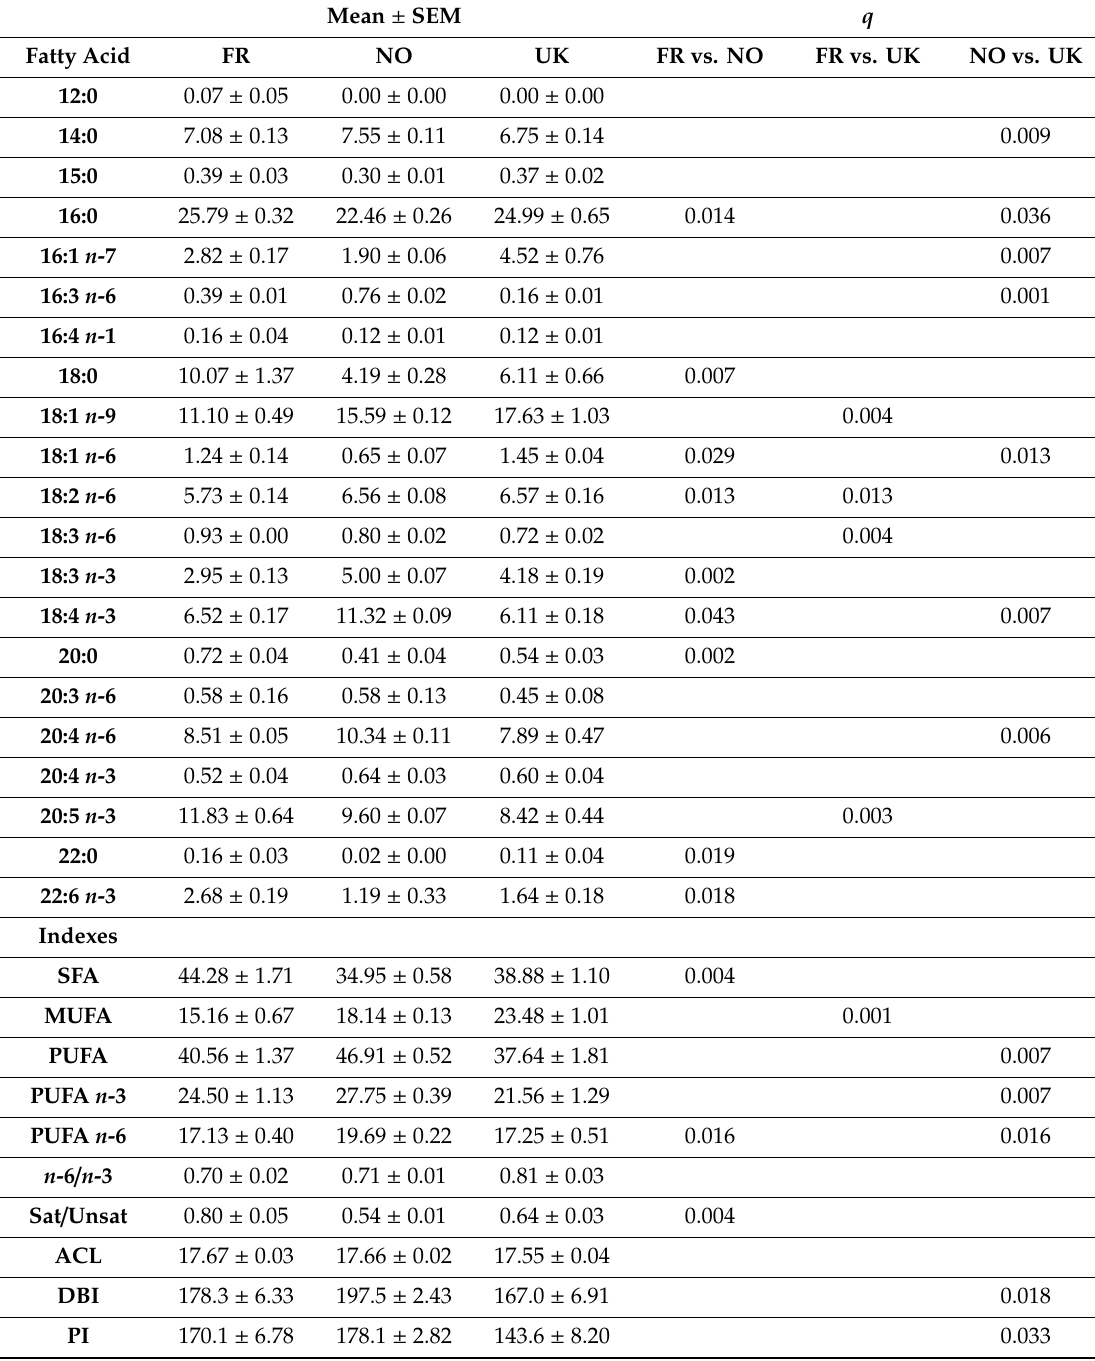
Table 1. Saccharina latissima fatty acid profile (%) of samples from di ff erent origins (FR—France; NO—Norway; UK—United Kingdom), derived nutritionally and functionally-relevant parameters from fatty acid